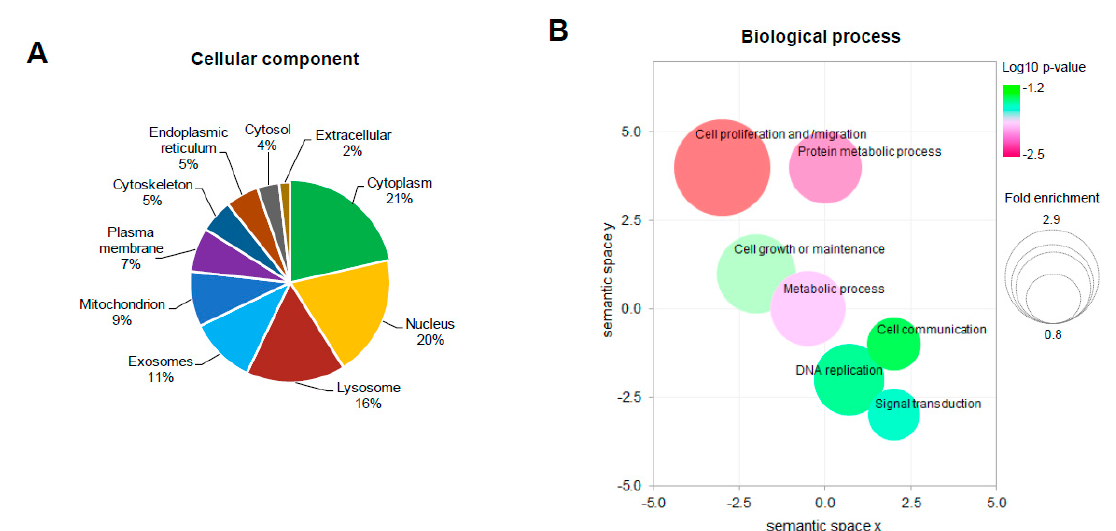
Figure 3. Functional annotation and classification of dysregulated proteins by GS treatment. The top enriched terms from the functional enrichment analysis of the dysregulated proteins and their distribution in the categories of cellular component ( A ) as a pie diagram, biological process ( B ) as bubble plot. Statistics of functional enrichment analysis can be found in Supplementary Table S2.